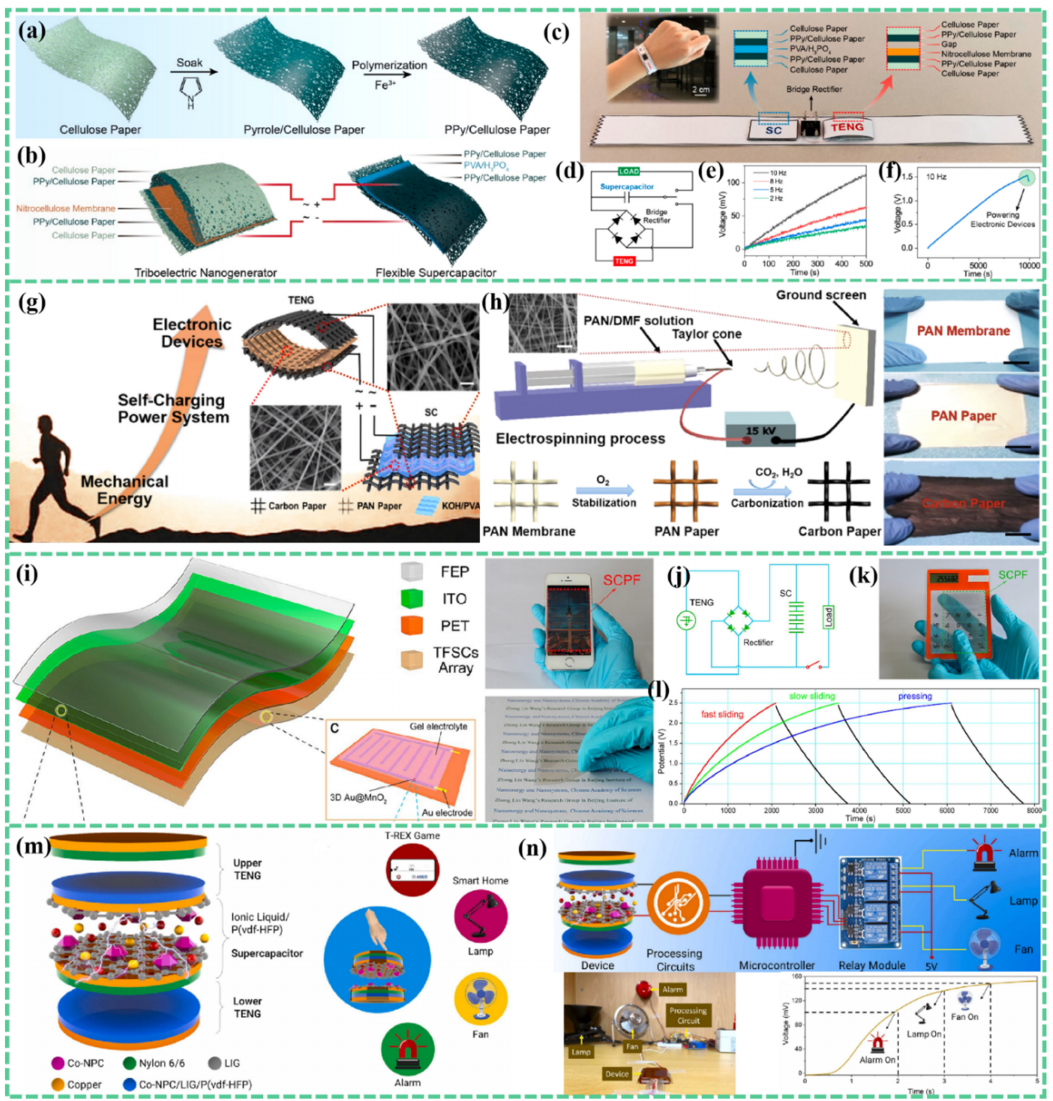
Figure 5. TENG-UPS with film structure. ( a – f ) A paper-based TENG-UPS consisting of a paper-based TENG and a paper-based SC. ( a ) Schematic diagram of manufacturing process of PPy coated cellulose paper. ( b ) Structure diagram of TENG-UPS. ( c ) Paper-based TENG-UPS wristband integrating the P-TENG and P-SC. ( d ) Equivalent circuit diagram. ( e ) Charging curves of the P-SC charged by the P-TENG at different frequencies. ( f ) Voltage–time curve of the P-SC that is charged by the P-TENG and then used to power an LCD. Reproduced with permission [80]. Copyright 2019, American Chemical Society. ( g – h ) An ultralight and flexible TENG-UPS via all electrospinning paper based on TENGs as energy harvester and all electrospinning paper-based SCs as storage device. ( g ) Schematic diagram of TENG-UPS. ( h ) Schematic illustration of the fabrication process. Reproduced with permission [81]. Copyright 2017, Elsevier Ltd. ( i – l ) A transparent and flexible UPSF that functions either as a TENG integrated with an energy storage unit or as a self-powered information input matrix. ( i ) Schematic illustration of the transparent and flexible TENG-UPS. ( j ) Circuit diagram of the transparent and flexible TENG-UPS. ( k ) Photograph of a calculator driven by the TENG-UPS. ( l ) Charging curves. Reproduced with permission [82]. Copyright 2016, American Chemical Society. ( m , n ) A TENG-UPS, which can store energy generated by TENG without rectifier or external circuit through “triboelectrochemical mechanism”. ( m ) Schematic diagram of TENG-UPS layer by layer structure. ( n ) System architecture for demonstrating the T-Rex game on the smartphone. Reproduced with permission [83]. Copyright 2022, Elsevier